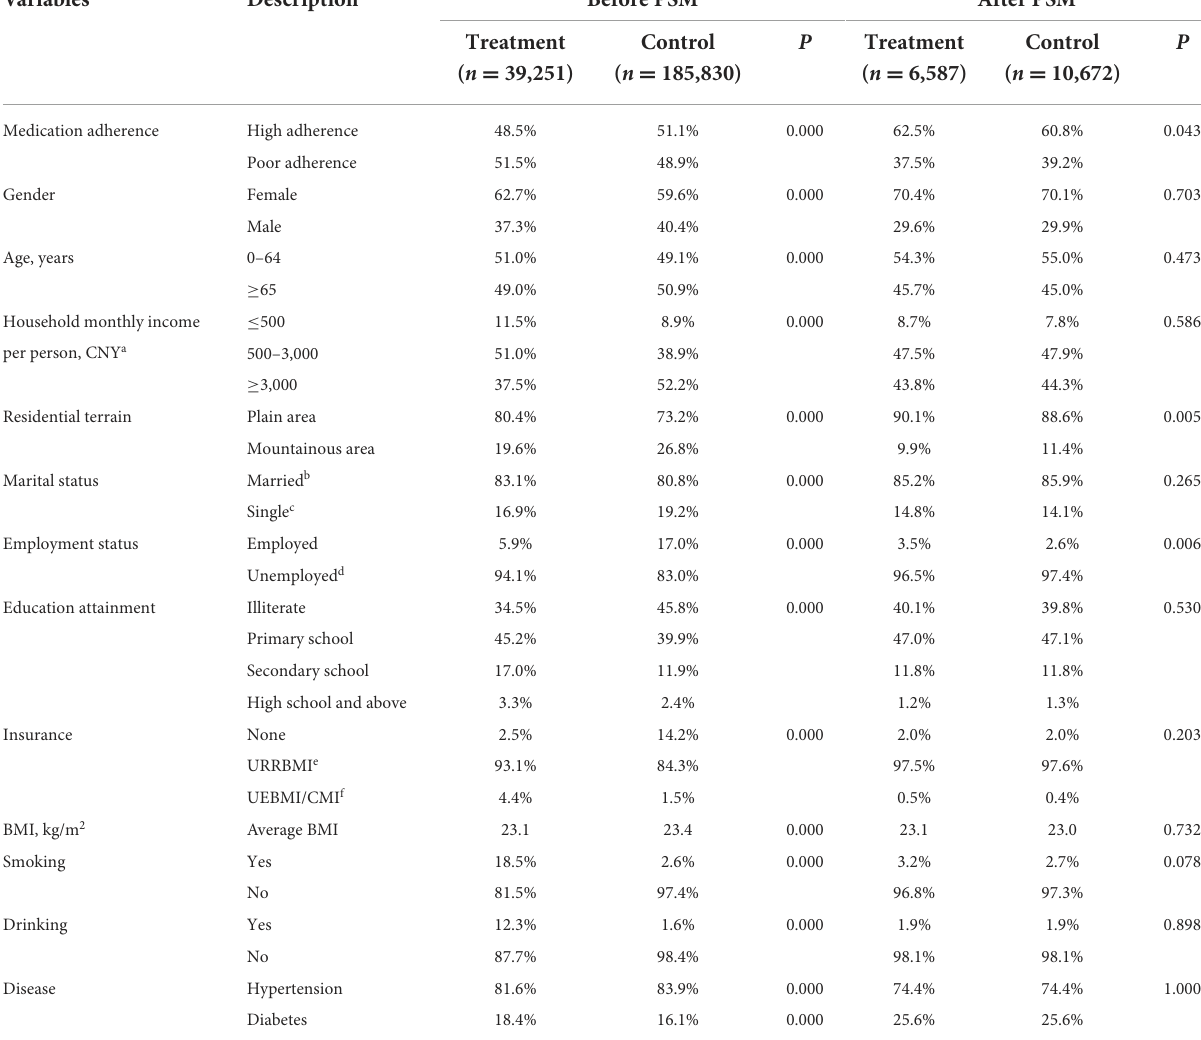
TABLE 1 Characteristics of study population before and after PSM.